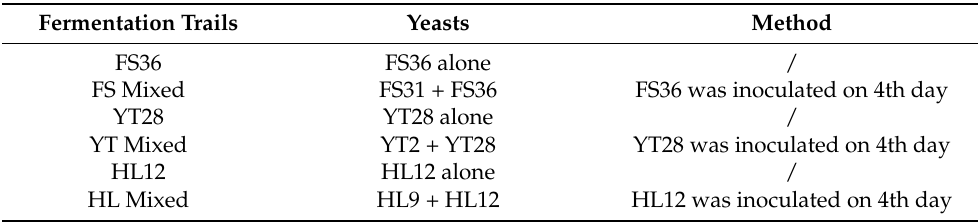
Table 2. The method of fermentation